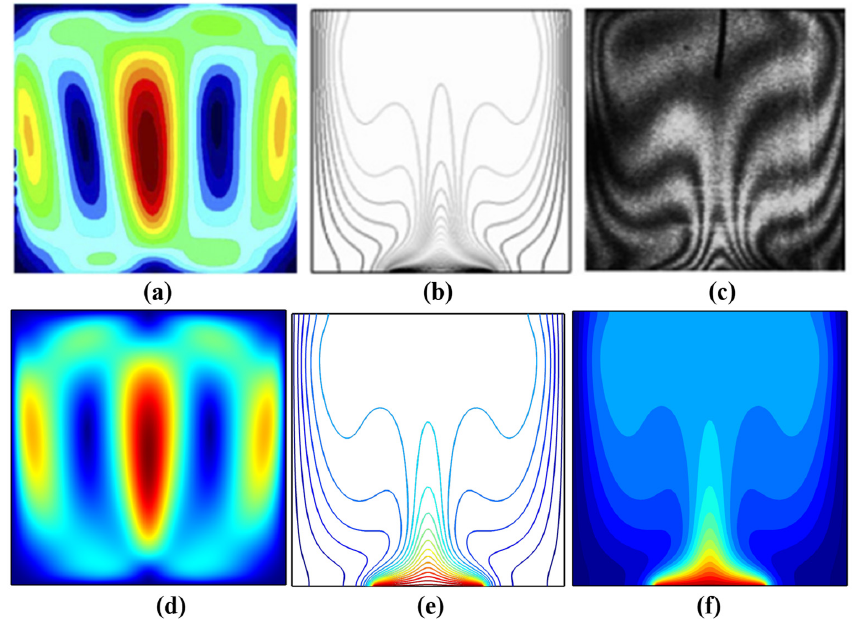
Figure 4. Comparison with the results of Corvaro and Paroncini [40] (Reprinted with permission from ref. [40]. Copyright 2007 Elsevier): flow field (experimental in ( a )), isotherms (numerical in ( b )), and isotherms (experimental in ( c )). The corresponding present numerical study is given in ( d – f